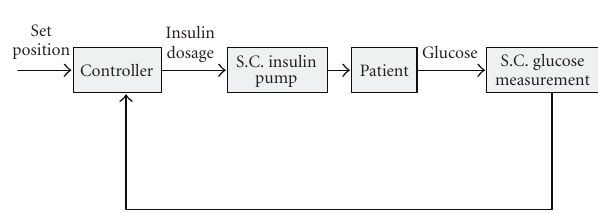
Figure 10: A control flow of closed-loop control models [15]. En- tire loop of the control is closed from outside by utilizing an insulin pump and in vivo blood glucose sensors. Both insulin injections and glucose measurements are carried out